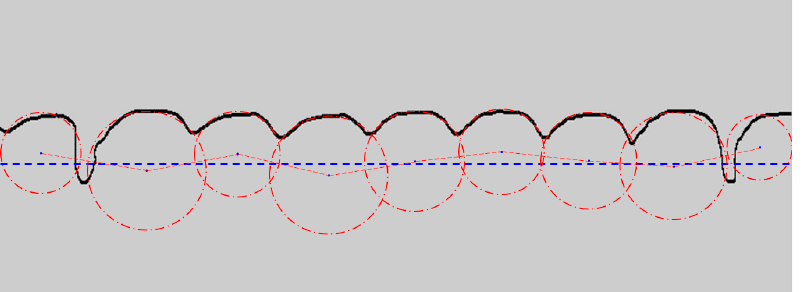
Figure 13. A recognition method is proposed in reference